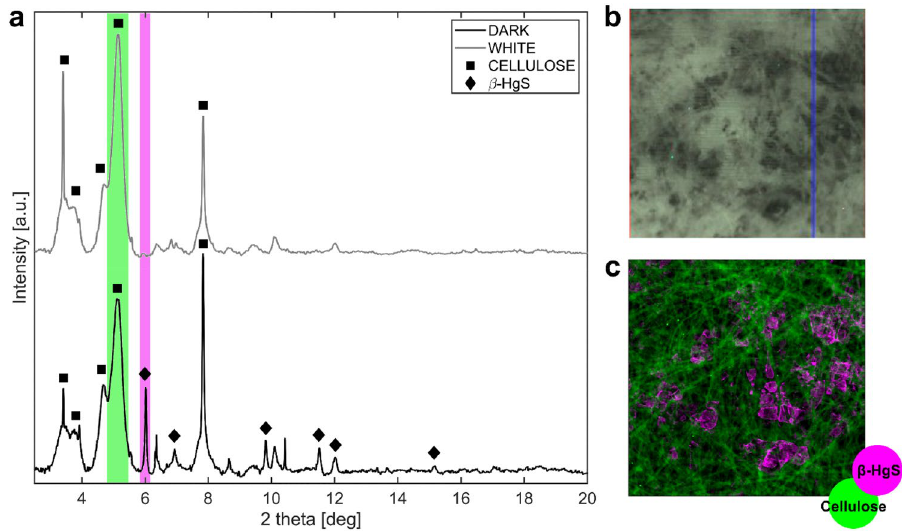
Figure 8. ( a ) HR-XRD spectra patterns of the white (grey) and dark (black) regions (radiation wavelength 0.35430407 Å). Squares and diamonds highlight the peaks related to cellulose and β-HgS respectively. ( b ) Visible light photograph of the area of the dark sample where SR µXRD mapping was performed. ( c ) SR µXRD images calculated by integrating XRD intensity over ROIs of XRD pattern, shown as green and purple rectangles in ( a ) for cellulose and metacinnabar